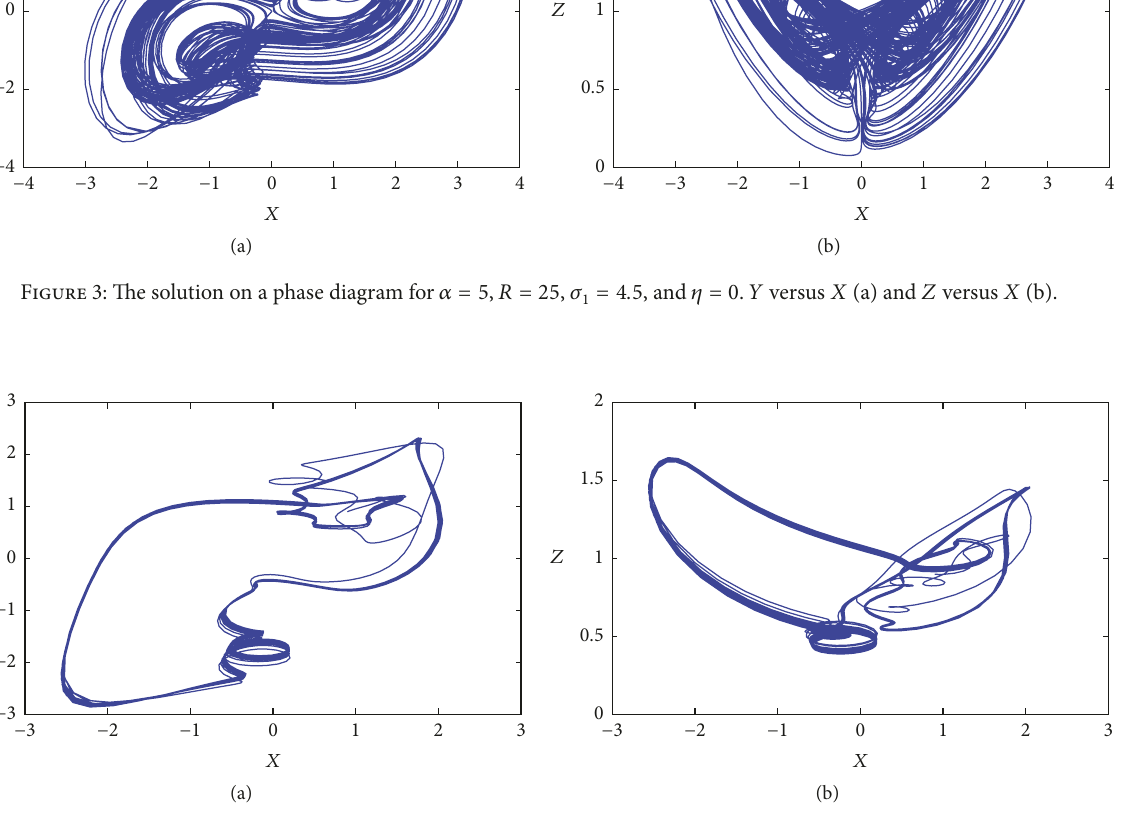
Figure 4: The solution on a phase diagram for 𝛼 = 5 , 𝑅 = 25 , 𝜎 1 = 4.5 , and 𝜂 = 6 . 𝑌 versus 𝑋 (a) and 𝑍 versus 𝑋 (b).